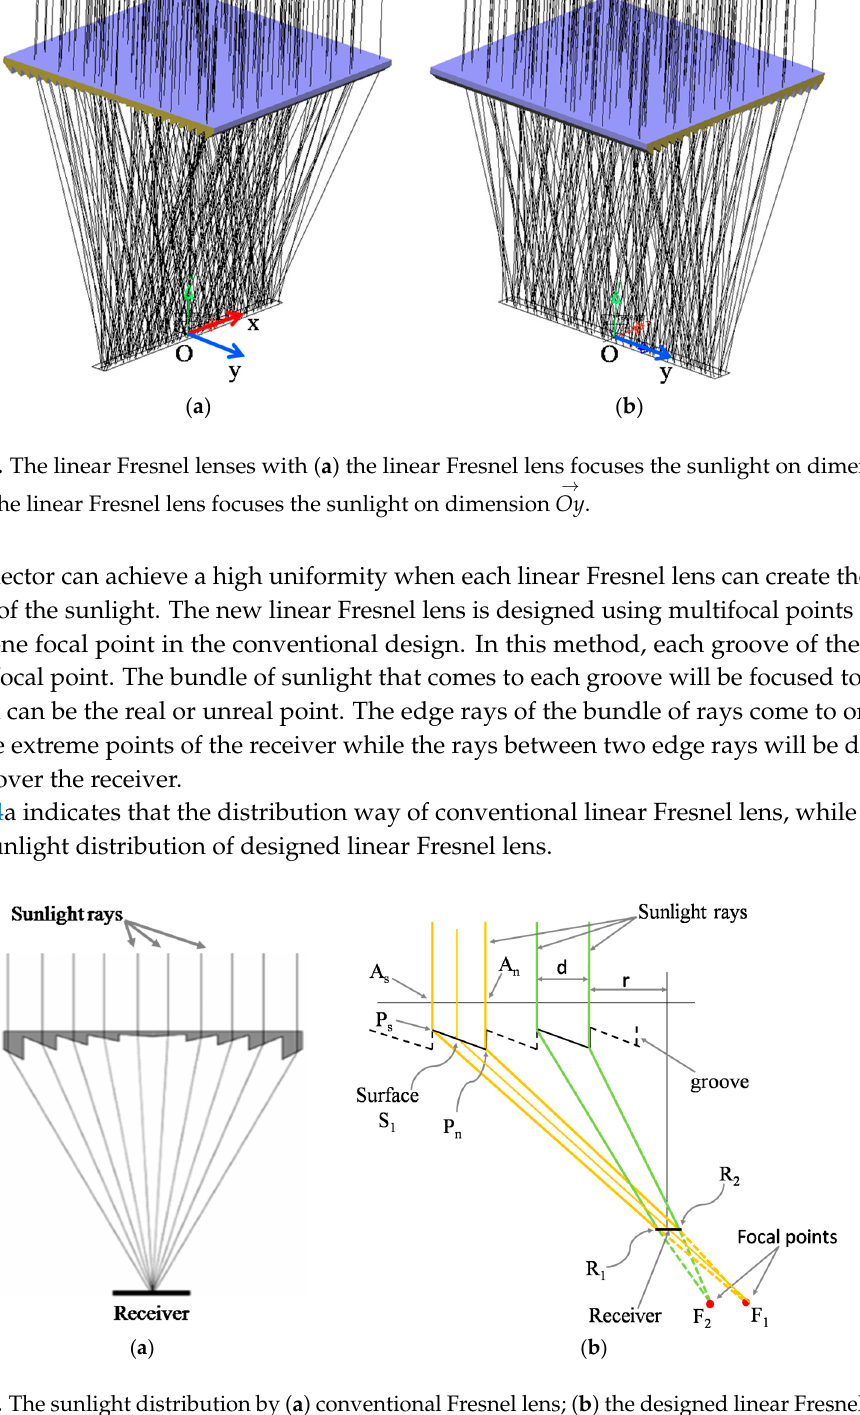
Figure 4. The sunlight distribution by ( a ) conventional Fresnel lens; ( b ) the designed linear Fresnel lens.